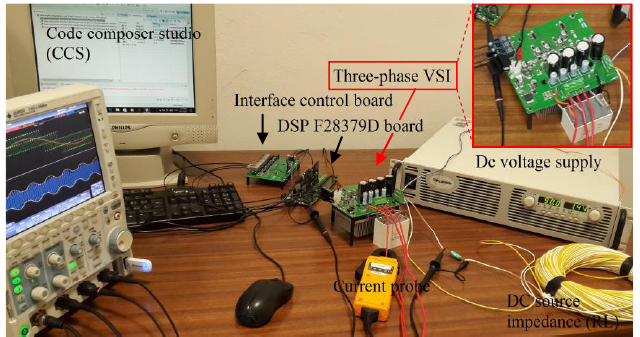
Figure 7. Experimental setup with a zoom of the three-phase inverter board.